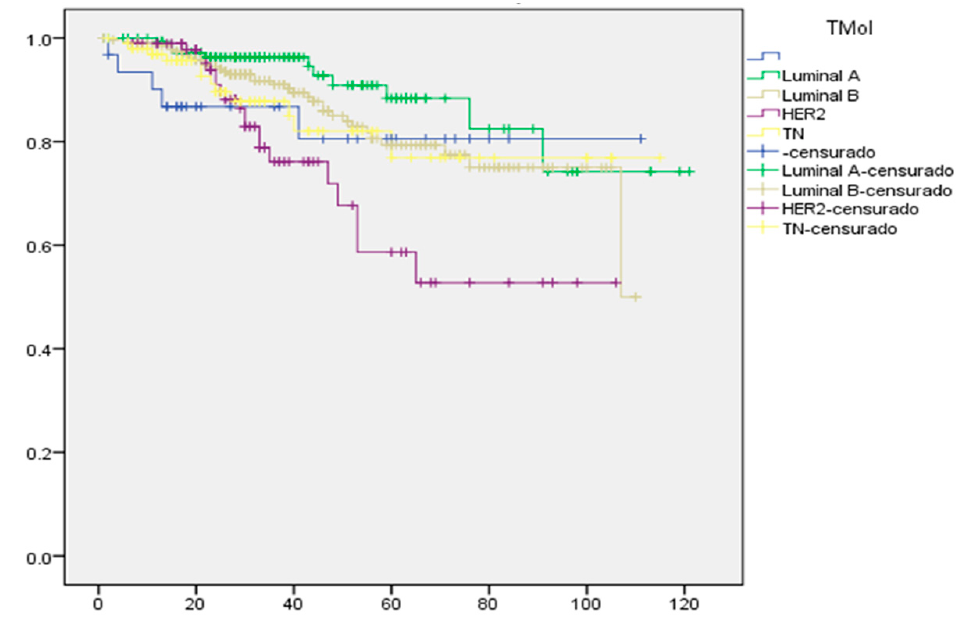
Figure 3. Kaplan–Meier plot of survival in Mexican women diagnosed with breast cancer. Follow-up of molecular type. Survival cumulative vs. time (month).